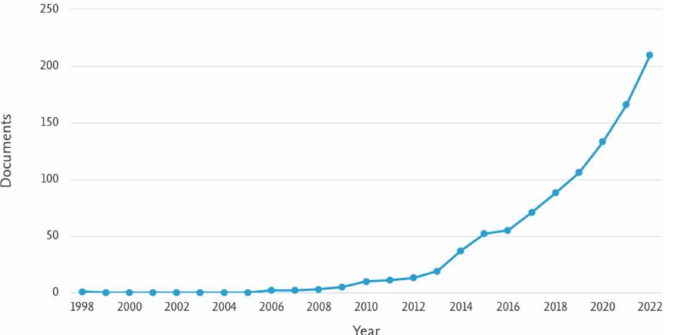
Figure 1. Papers containing “bio-based coating” in their keywords, published from 1998 to November 2022 (source: Scopus database).